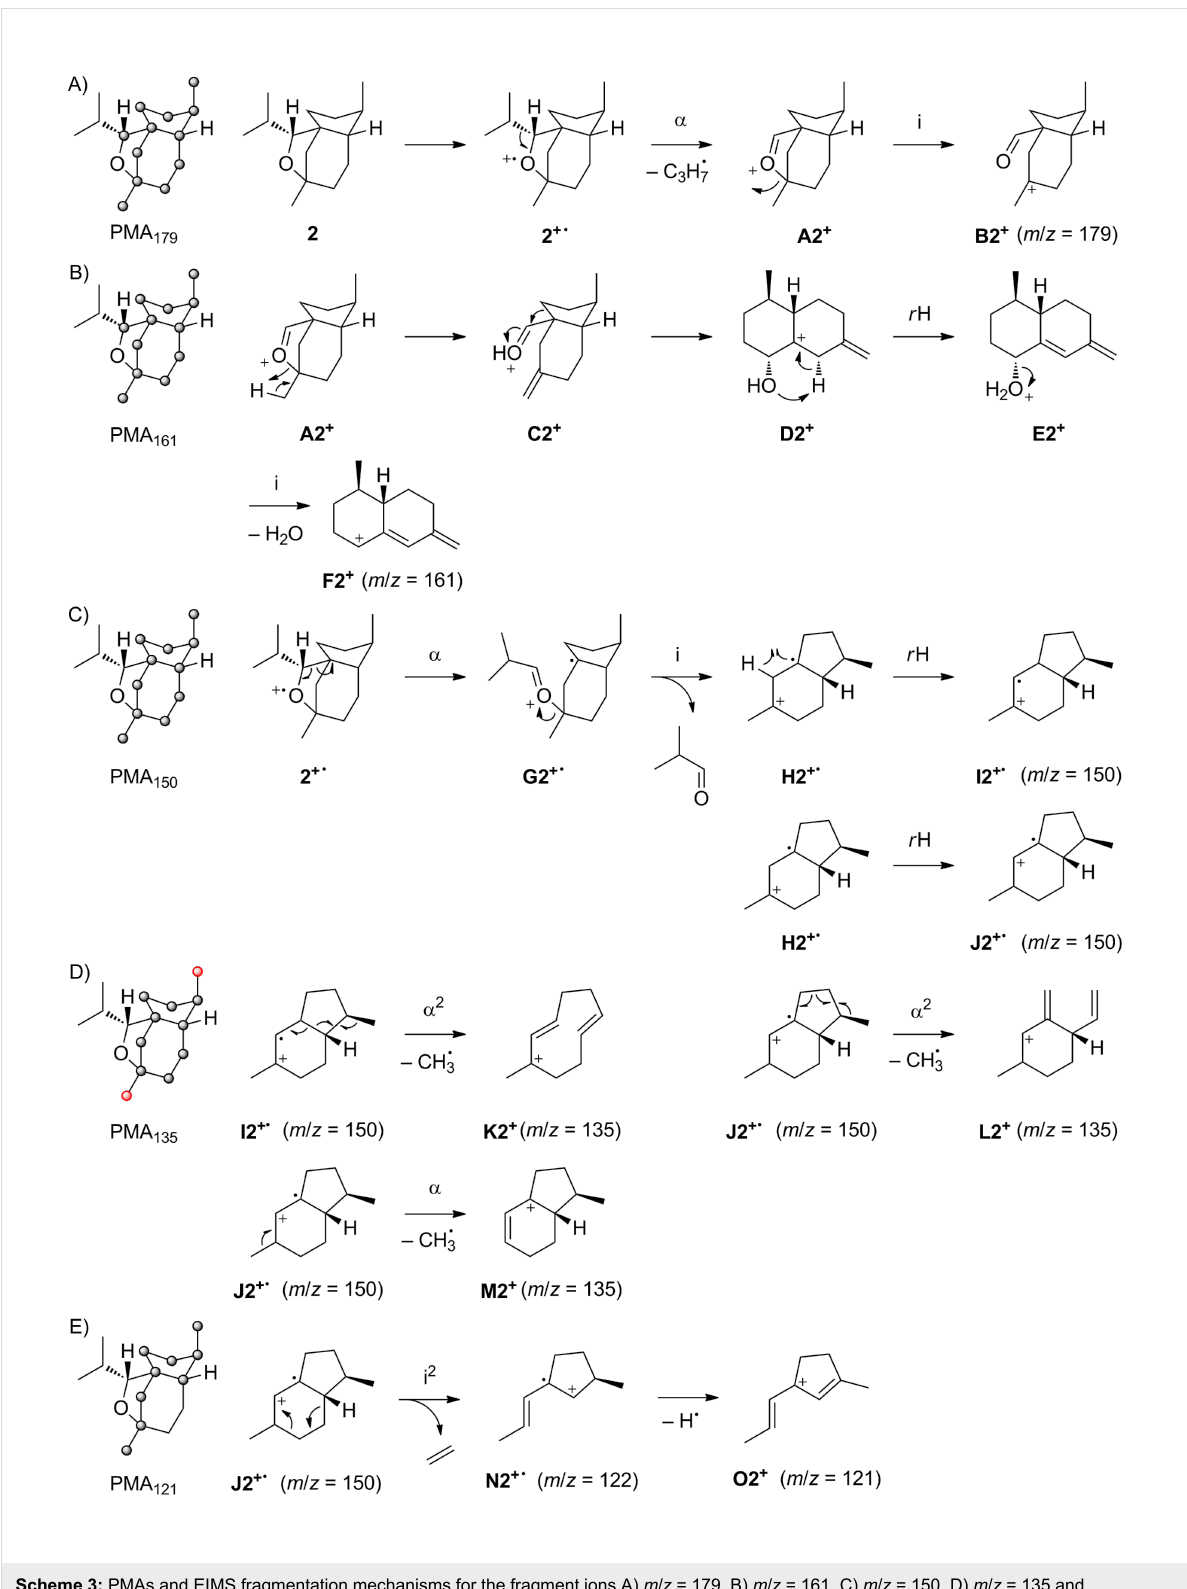
Scheme 3: PMAs and EIMS fragmentation mechanisms for the fragment ions A) m / z = 179, B) m / z = 161, C) m / z = 150, D) m / z = 135 and E) m / z = 121 of 2 . Black carbons contribute fully and red carbons contribute partially to the formation of a fragment ion. α : α -cleavage, r H: hydrogen rearrangement, i: inductive